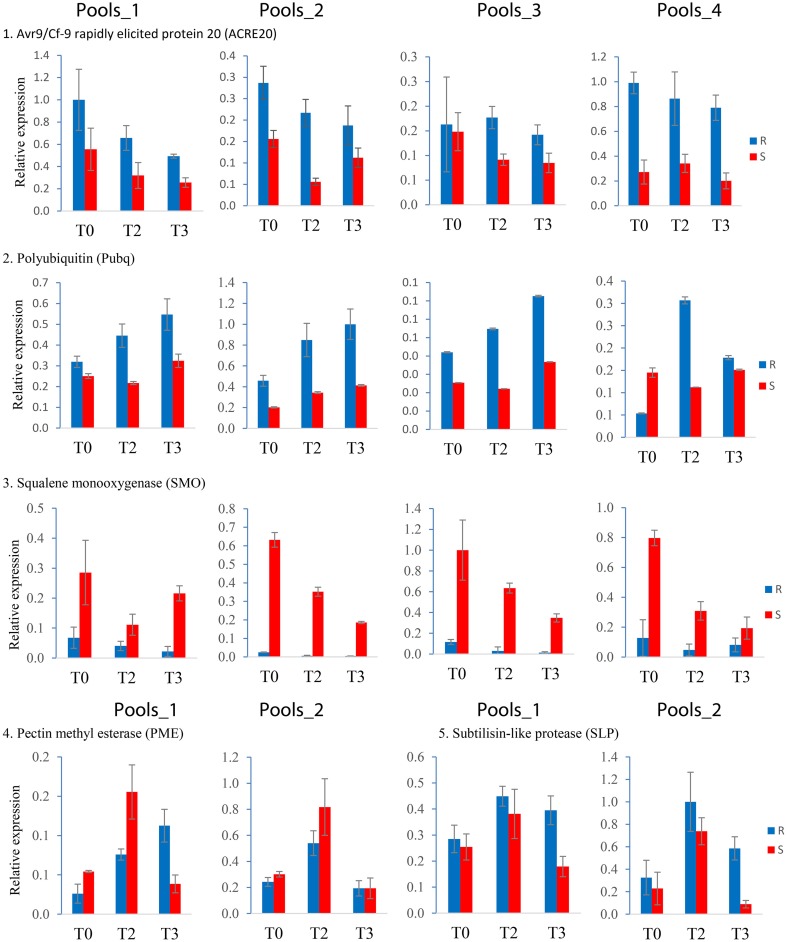
Expression patterns obtained by qRT-PCR of the five most reproducible candidate genes. Resistant (R) and susceptible (S) pools are shown as blue and red bars, respectively, at infection time points T0, T2, and T3. Expression of ACRE20, Pubq, and SMO was quantified in Pools_1, _2, _3, and _4, of PME and SLP in Pools_1 and _2. The bars represent the data from one representative out of three independent infection experiments. Error bars were derived from two technical replicates.